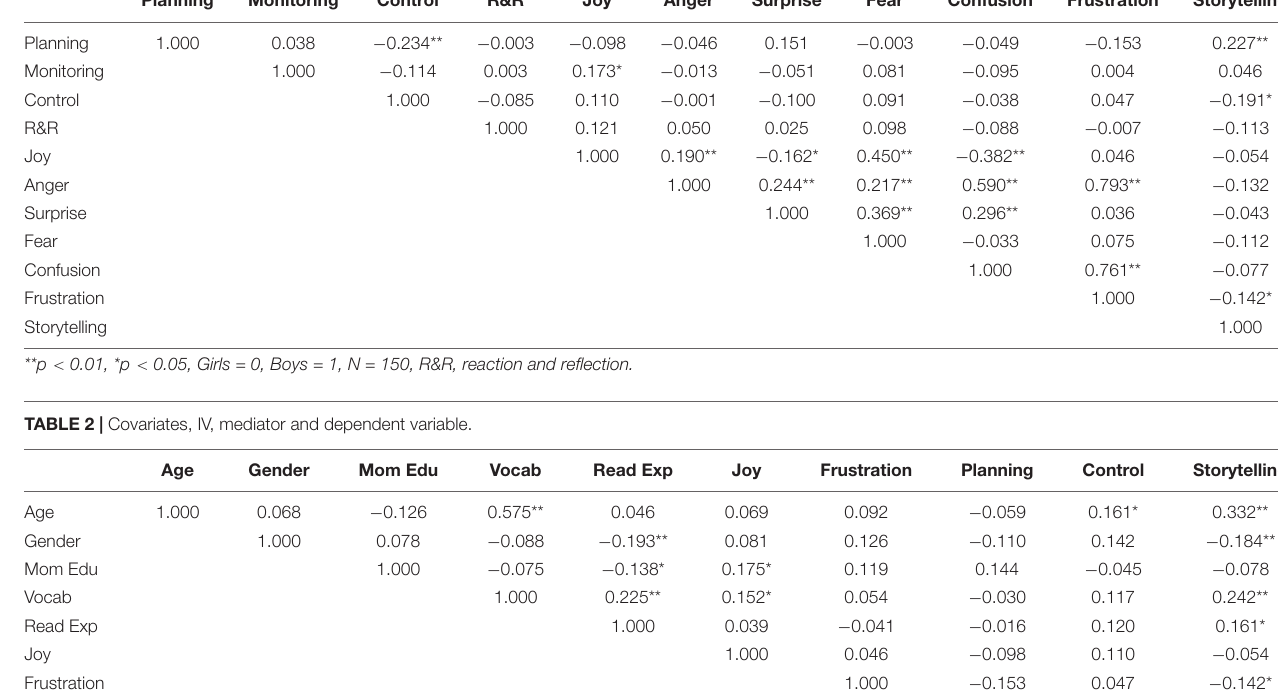
TABLE 1 | Emotions, SRL strategies and storytelling scores. Planning